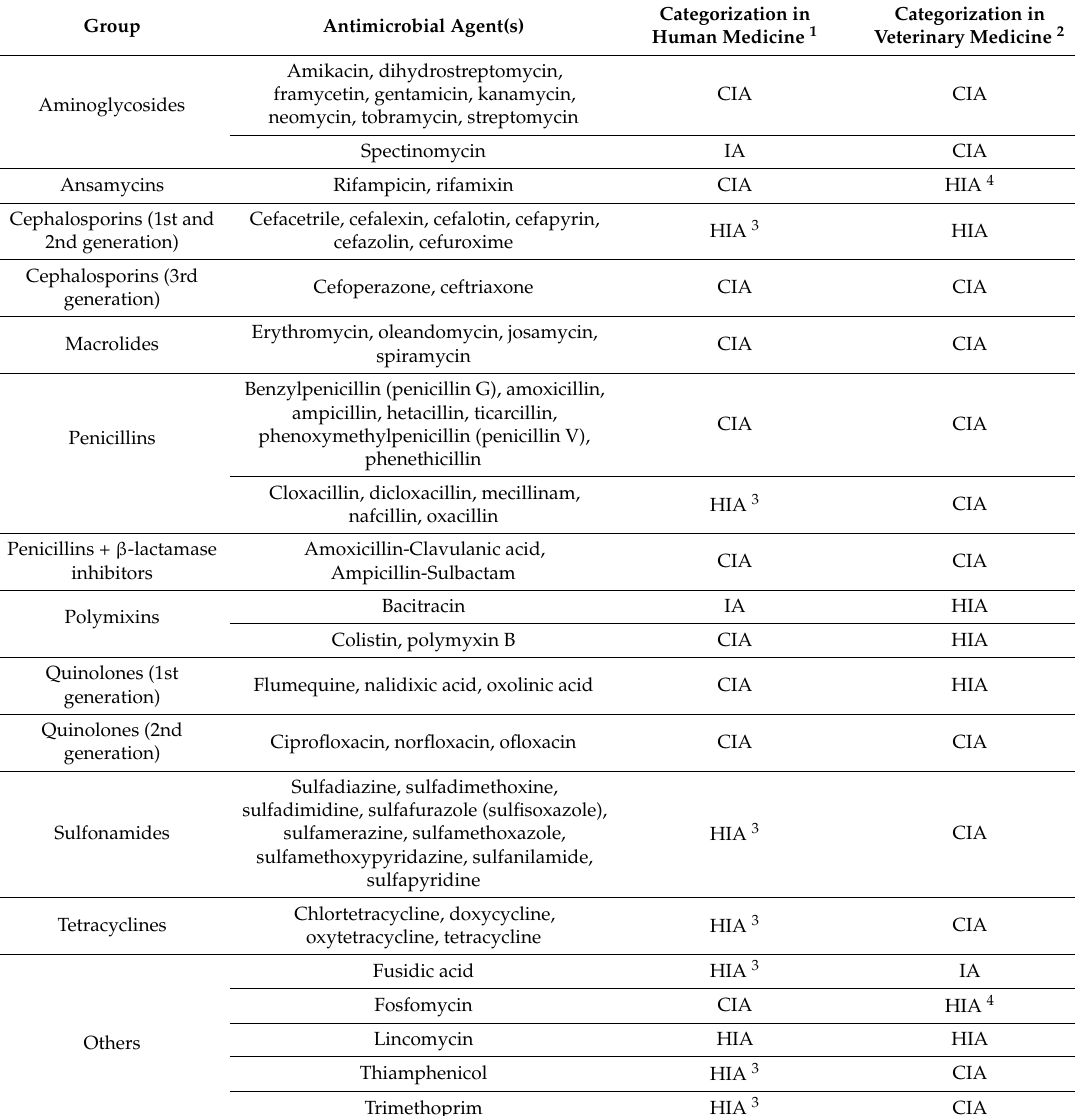
Table 1. Antimicrobials used in both human and veterinary